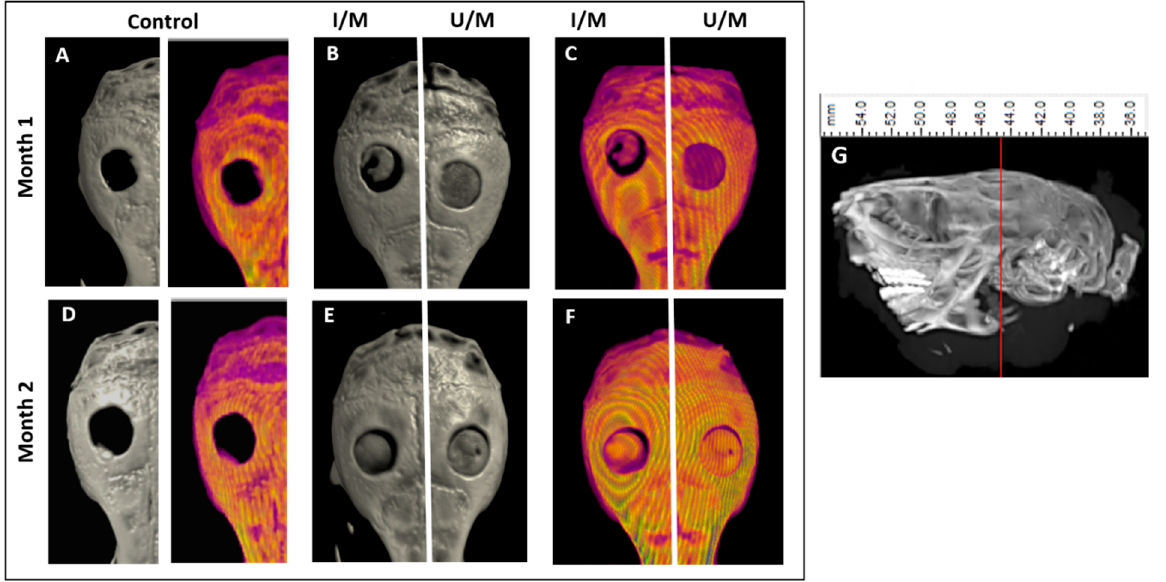
Figure 4. Micro-CT analysis in calvarial defect model. ( A – F ) Top view of the coronal plane of the mouse skull. In ( A , D ) negative controls (untreated calvarial defect). In ( B , C , E , F ) the membranes inside the critical defects in the cranial vault are observed. ( G ) Side plan and dimensions.